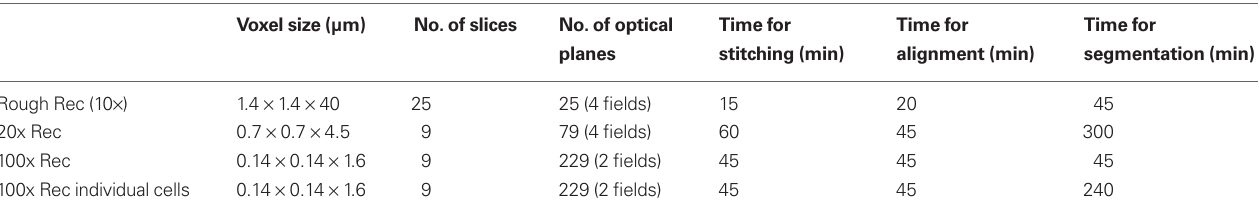
Table 1 | Voxel size, number of slices, and optical planes, and approximate time required to perform stitching, alignment, and segmentation in each reconstruction described in this study.